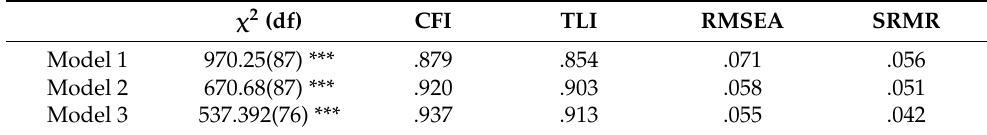
Table 4. Decomposition of Variance for model 2 (N = 2007).